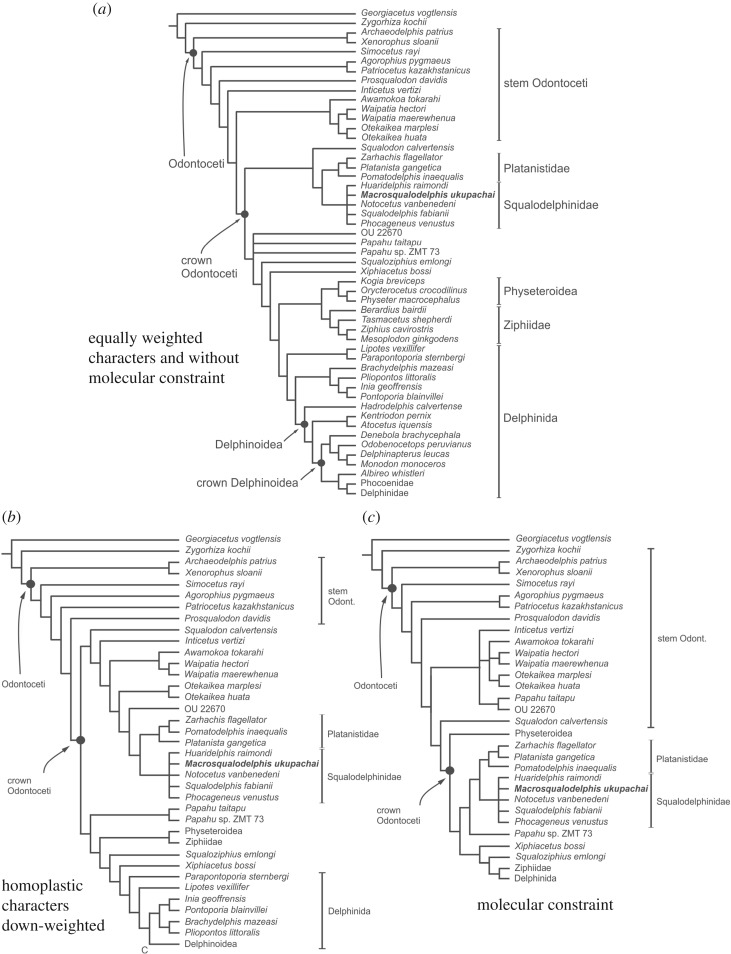
Alternative phylogenetic analyses using a modified matrix of Tanaka & Fordyce [6] and Lambert et al. [20]. (a) Strict consensus tree for the analysis with equally weighted characters and without molecular constraint; (b) strict consensus tree for the analysis with down-weighted homoplastic characters and without molecular constraint; (c) strict consensus tree for the analysis with equally weighted homoplastic characters and with molecular constraint (same result with down-weighted homoplastic characters). Note that in all of these analyses: (1) Macrosqualodelphis is inside Squalodelphinidae; (2) Squalodelphinidae are a monophyletic group and (3) Platanistidae and Squalodelphinidae are sister groups. The relationships within some clades (e.g. Delphinoidea in tree (b) and Delphinidae in tree (c)) were not shown because they are not relevant to the position of Macrosqualodelphis.